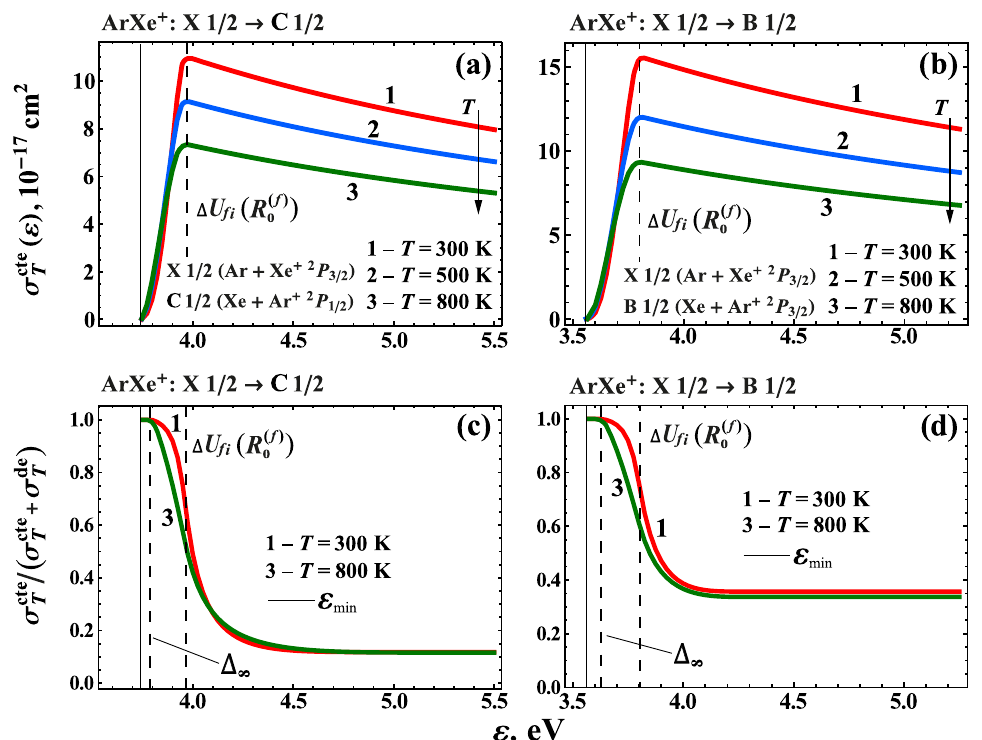
Figure 5. ( a , b ) Cross sections of electron-impact excitation σ cte of ArXe + ions to charge transfer states: T ArXe + ( X 1/2 ) + e → ArXe + ( C 1/2 ) + e → XeAr + + e ( a ), A-type transitions) and ArXe + ( X 1/2 ) + e → ArXe + ( B 1/2 ) + e → XeAr + + e ( b ), B-type transitions) at gas temperatures T = 300, 500, 800 K. ( ε ) / ( σ cte ( ε ) + σ de ( ε )) , of process (2) to the total cross section of charge ( c , d ) Relative contribution, σ cte T T T exchange of ArXe + ions induced by electron-impact via transitions of type A ( c ) and B ( d